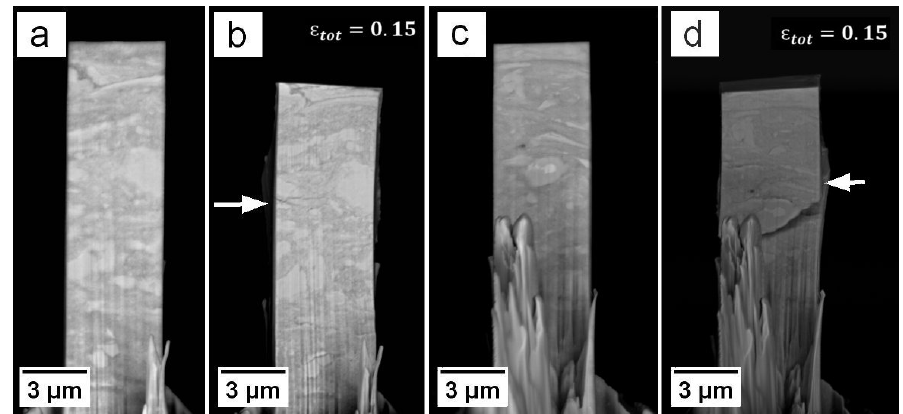
Figure 5. BSE images of sample 3 from front and backside ( a , c ) before and ( b , d ) after compression to a total strain of 15%. The latter show the formation of a crack (white arrows) propagating through the whole pillar, which seems to be the reason for the different flow